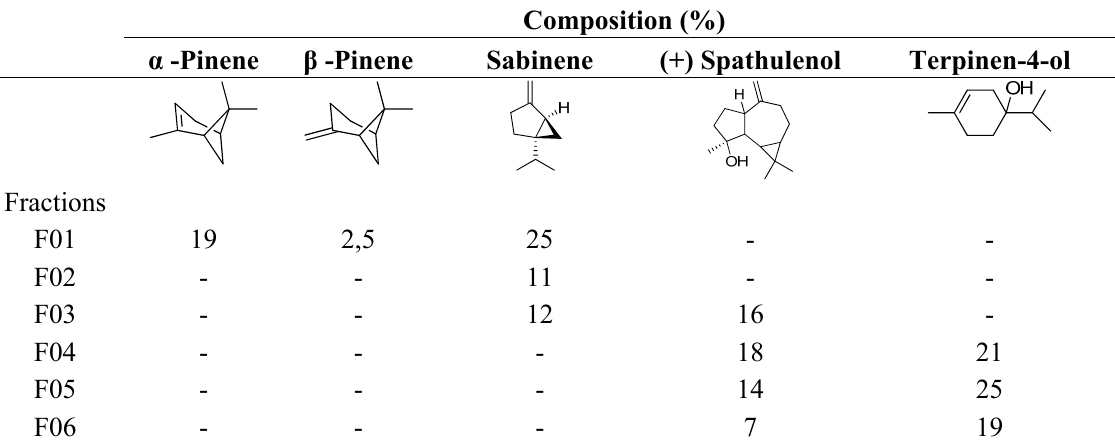
Table 3. Composition of S. molle oil fractions tested for antibacterial